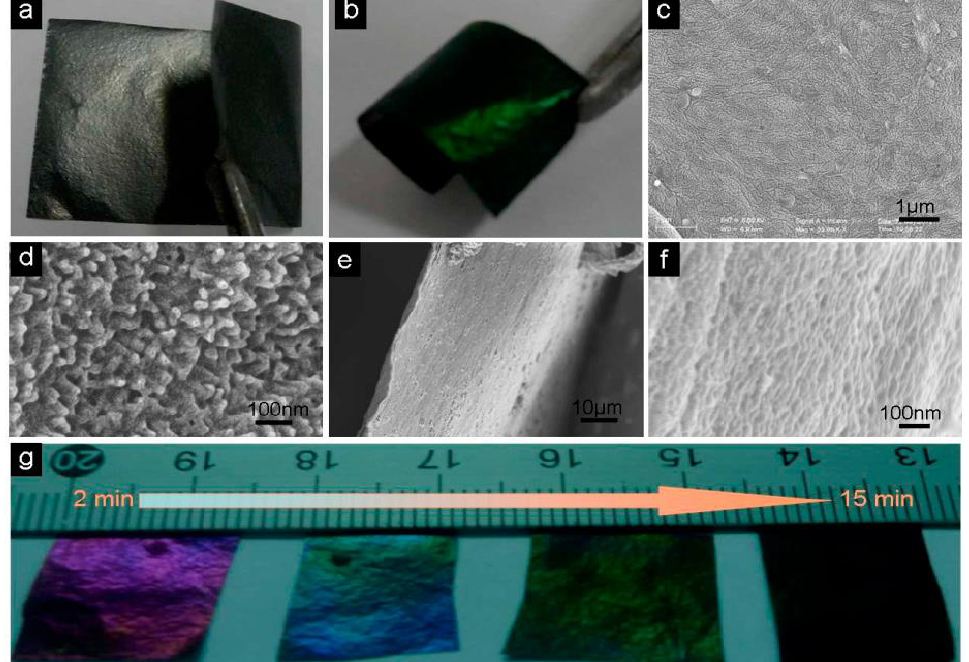
Figure 10. ( a ) Flexible graphene paper. ( b ) Graphene/PANI paper. ( c , d ) SEM micrographs of the surface of graphene/PANI paper. ( e , f ) SEM micrographs of cross sections of graphene/PANI paper. ( g ) Graphene/PANI papers with different electropolymerization times (From left to right: 2, 5, 10, 15 min). Reproduced from ref. [51], copyright 2013, Royal Society of Chemistry.